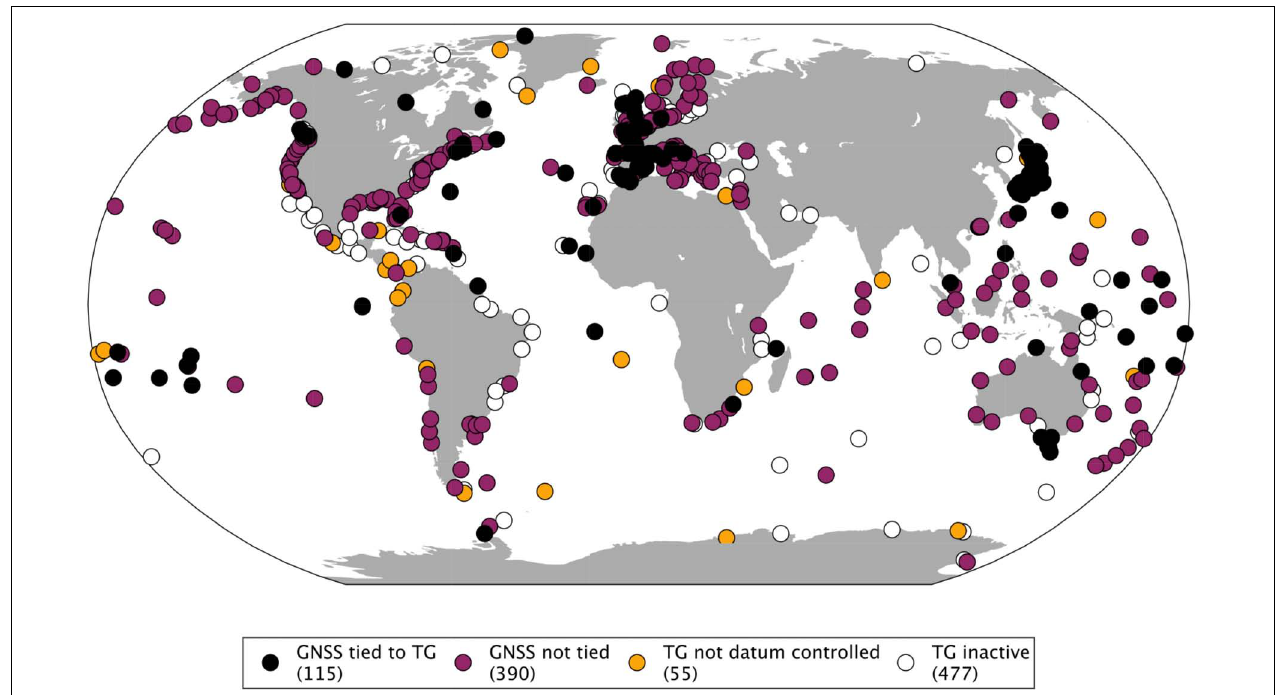
FIGURE 3 | Tide gauges and collocated GPS. Number of stations in each category is given in